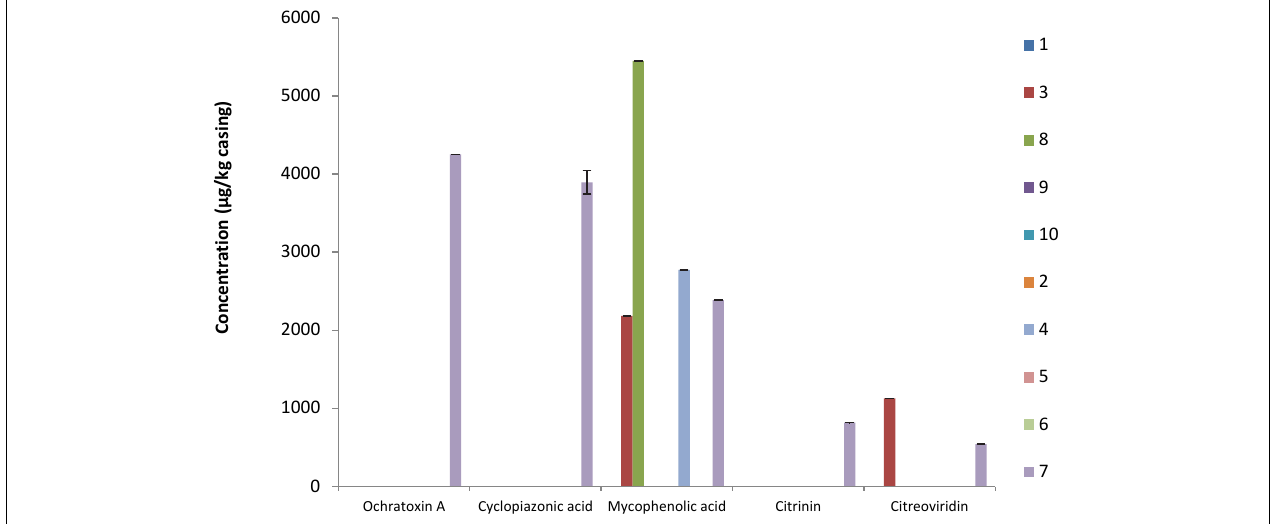
FIGURE 3 | Mycotoxin quantification for the 10 dry fermented sausage casing samples. Results are expressed as micrograms mycotoxin per kilogram casing for average values obtained from three independent fermentation batches. Samples S1, S3, S8, S9, and S10 were sausages voluntarily inoculated with commercial molds, while S2, S4, S5, S6, and S7 were sausages naturally colonized by in-house mycobiota.